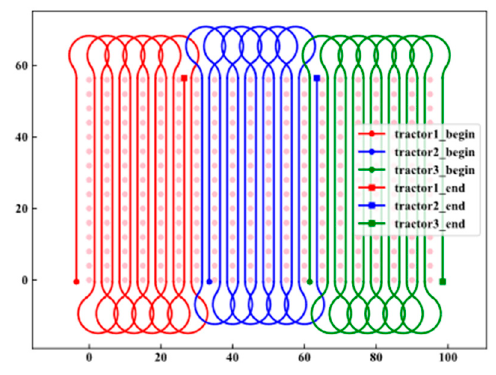
Figure 3. Schematic diagram of partition operation.